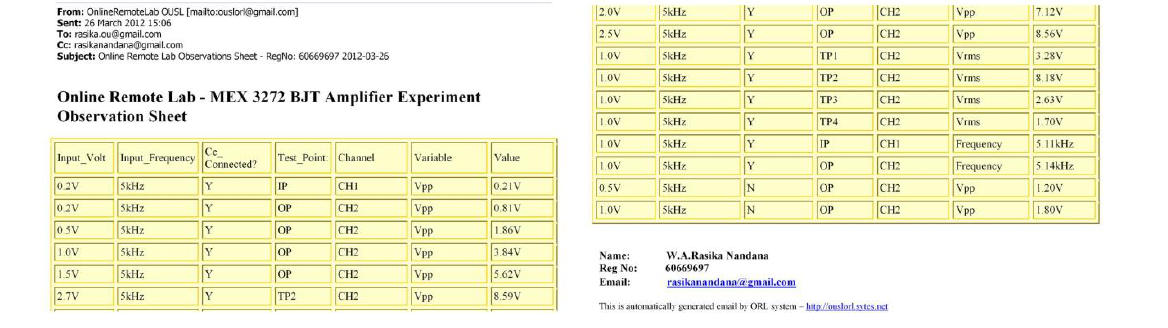
Figure 6 The generated observation sheet System Validation and Limitations Communication